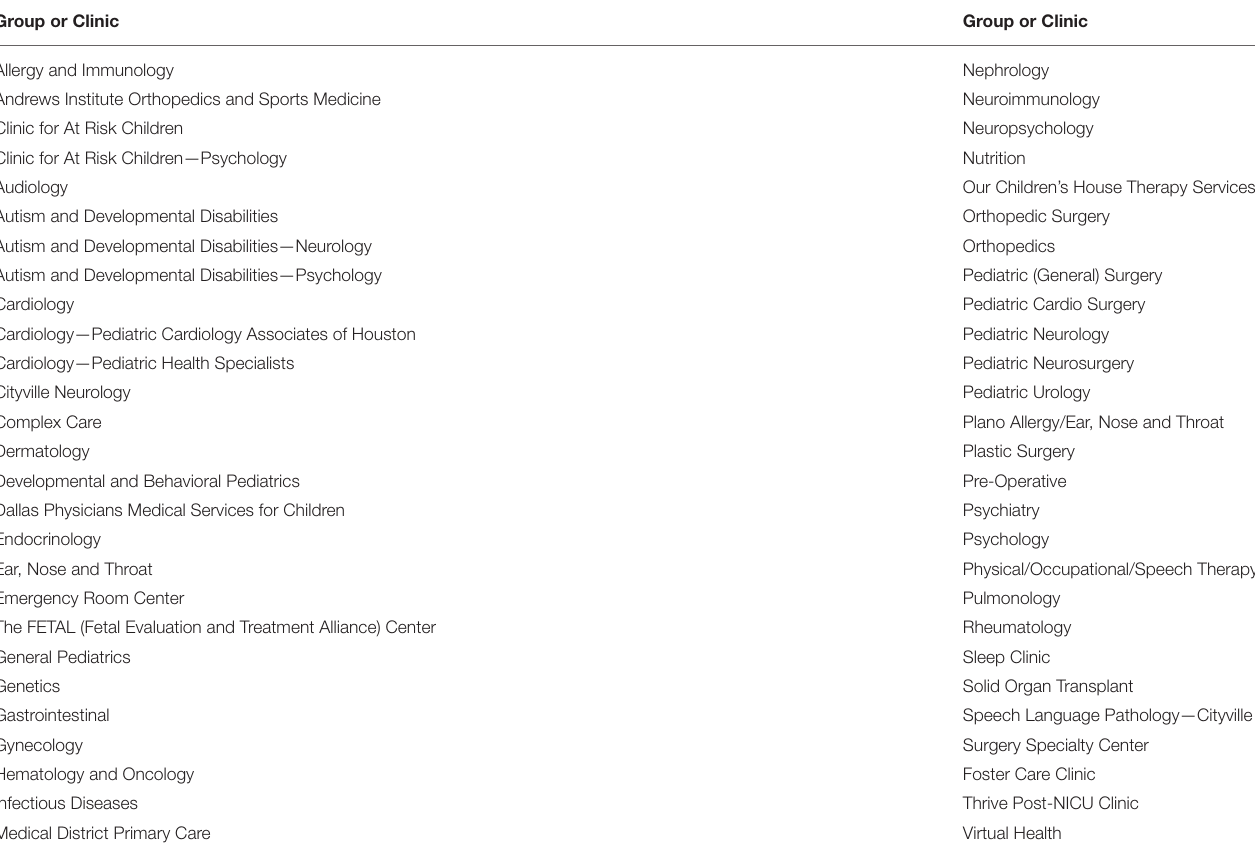
TABLE 1 | Ambulatory telemedicine groups/clinics, Children’s Health System of